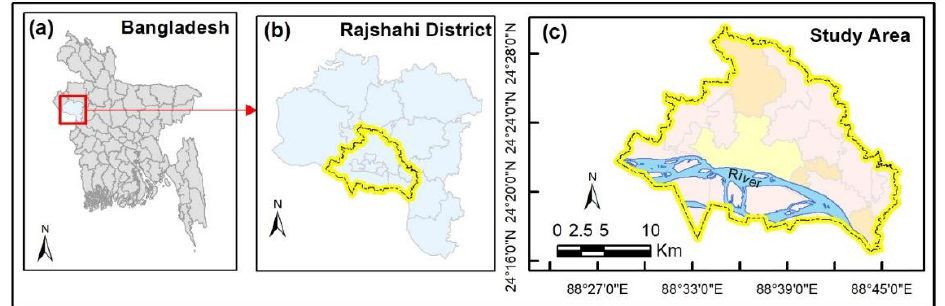
Figure 1. ( a ) Location of Rajshahi district in relation to Bangladesh; ( b ) location of the study area in relation to Rajshahi district; ( c ) administrative boundary of the study area.